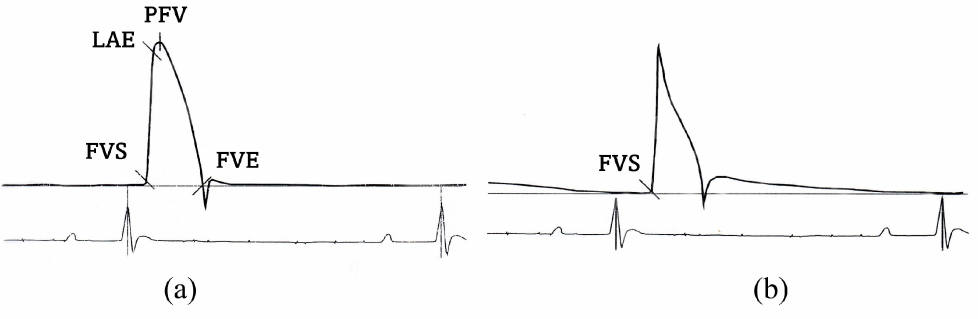
Figure 2. Doppler spectral variables. ( a ) Ascending aorta: FVS (Flow Velocity Start), LAE (Linear Acceleration End), PFV (Peak Flow Velocity), FVE (Flow Velocity End), and ( b ) Abdominal aorta: